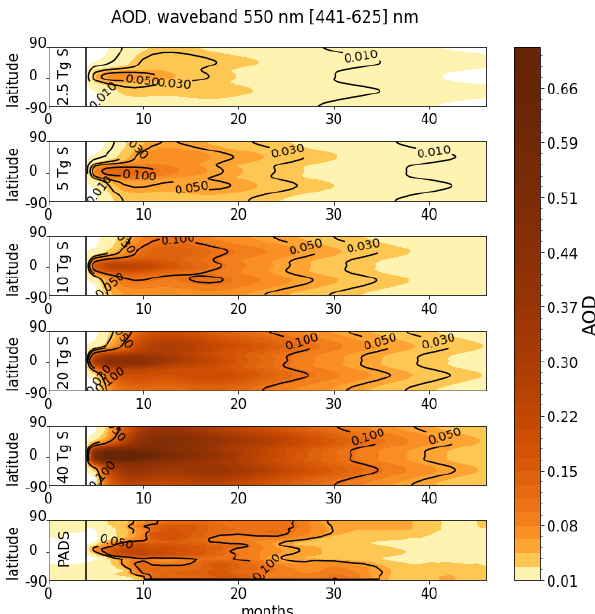
Figure 1. Time evolution of the aerosol optical depth (AOD) for the five volcanically perturbed EVAens runs (2.5, 5, 10, 20 and 40Tg S) and the PADS Mt. Pinatubo compilation. The zonal average AOD is shown for all latitudes considering the 550nm waveband (441–